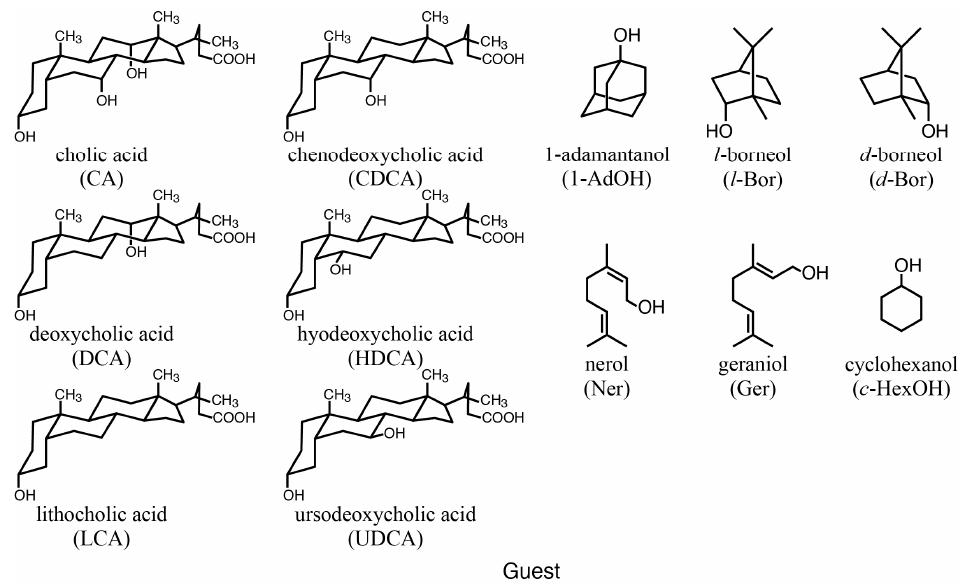
Figure 4. Structures of guests.